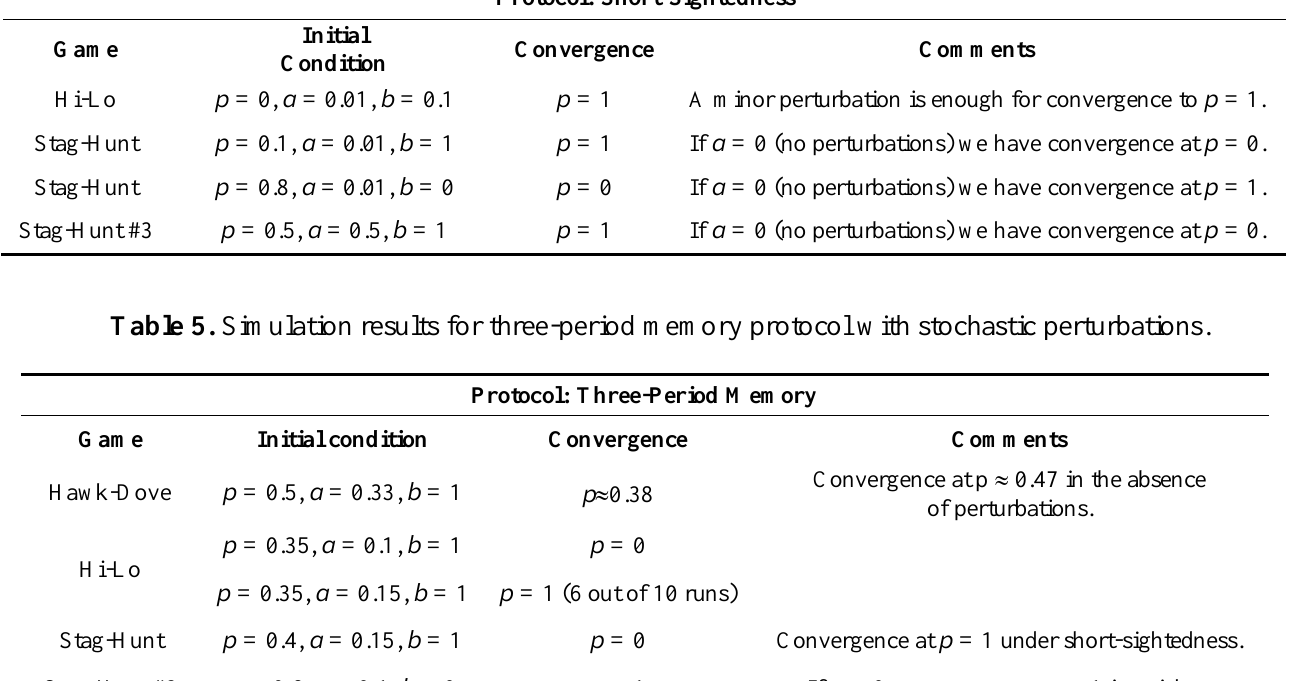
Table 4. Simulation results for short-sightedness protocol with stochastic perturbations. Protocol: Short-Sightedness